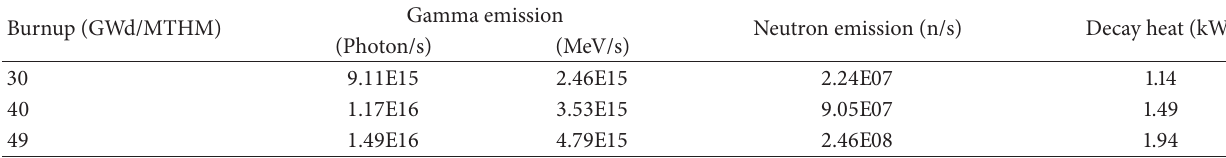
Table 6: The radioactive source specification and decay heat of the BNPP SFA (3-year cooling